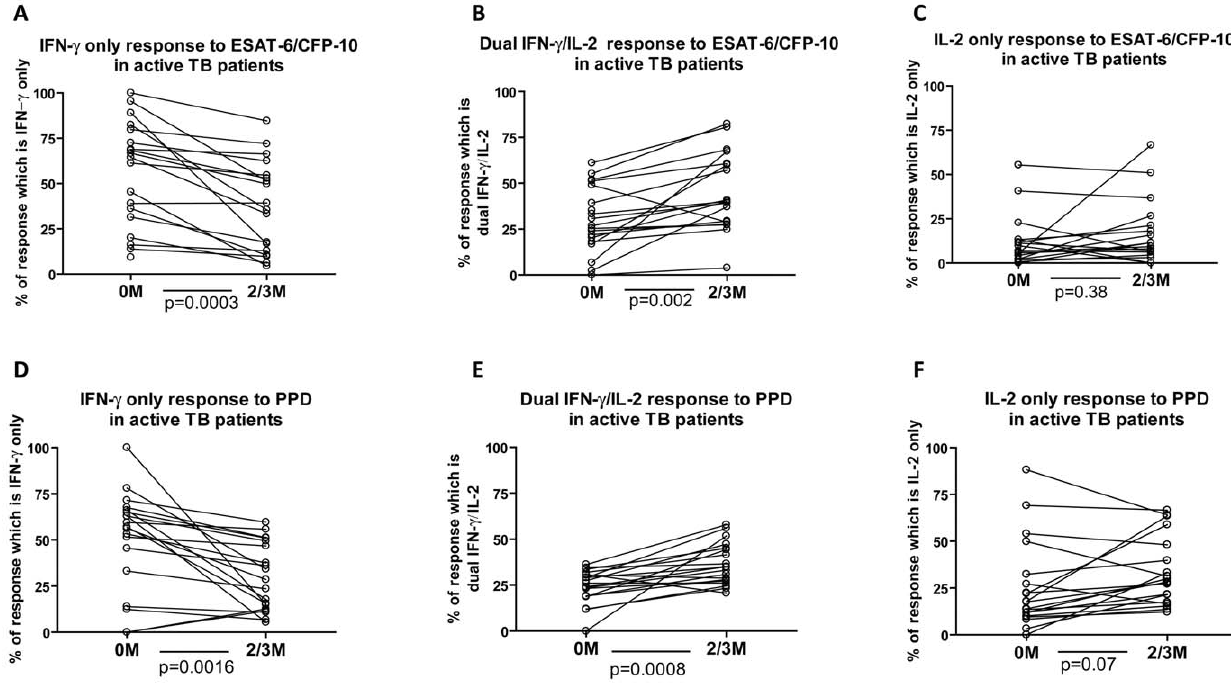
Figure 5. Cytokine responses to ESAT-6/CFP-10 and PPD in patients with active TB followed longitudinally before and during treatment (2 or 3 months of treatment). PBMC from 19 patients with active TB were isolated before treatment and after 2 or 3 months treatment and stimulated with ESAT-6/CFP-10 (A–C) or PPD (D–F) and the number of IFN- c -only secreting cells (A,D) Dual IFN- c /IL-2–secreting cells (B,E) and IL- 2-only secreting cells (C,F) were enumerated by fluorescence-immunospot. Data are expressed for all responding patients as the percentage of the total number of cytokine-secreting cells detected which were IFN- c -only, IL-2-only or dual IFN- c /IL-2–secreting cells.